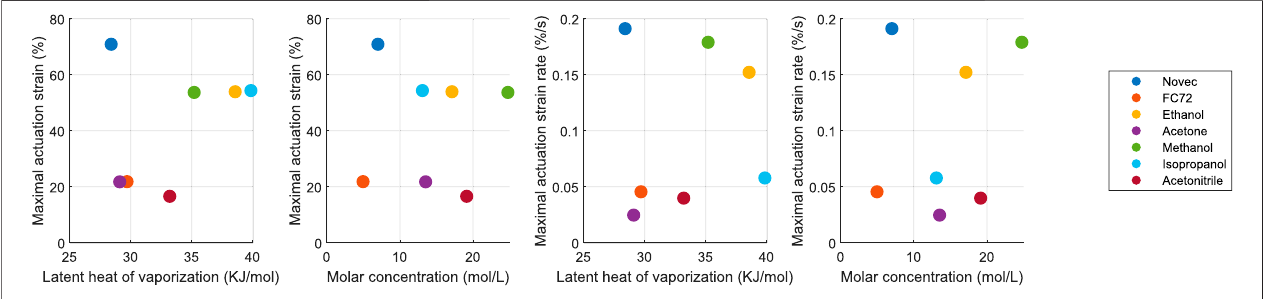
Frontiers in Robotics and AI |